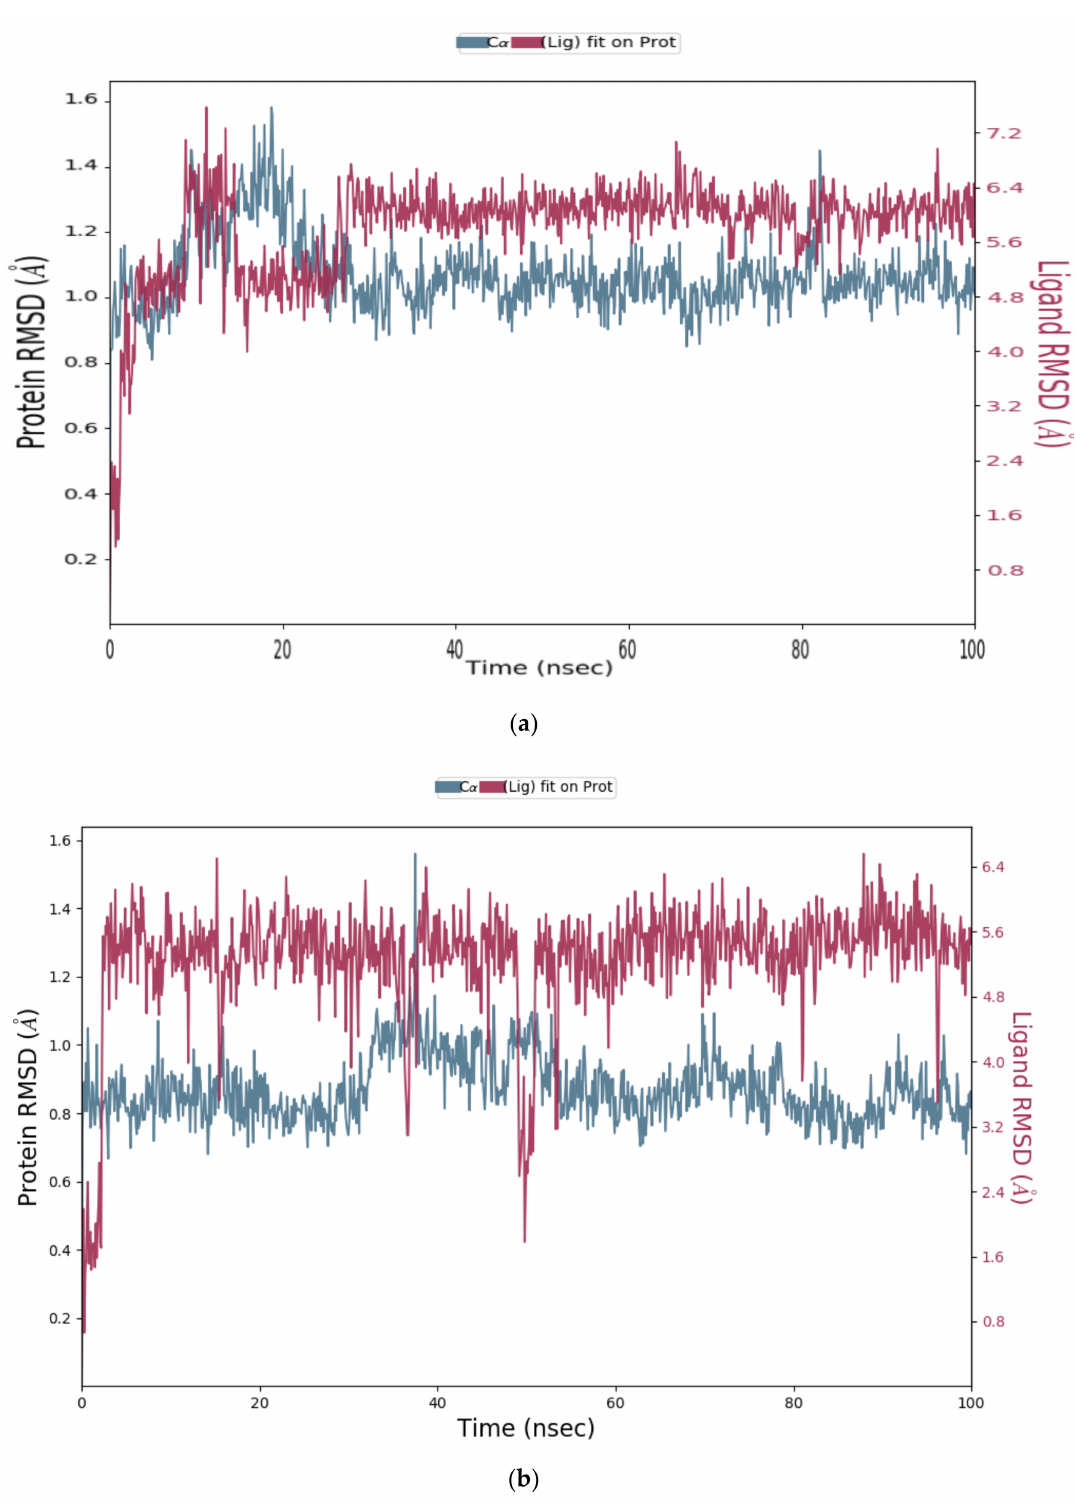
Figure 13. RMSD graph of ( a ) Cathepsin S-DTBN; ( b ) Cathepsin S-iDTBN covalent